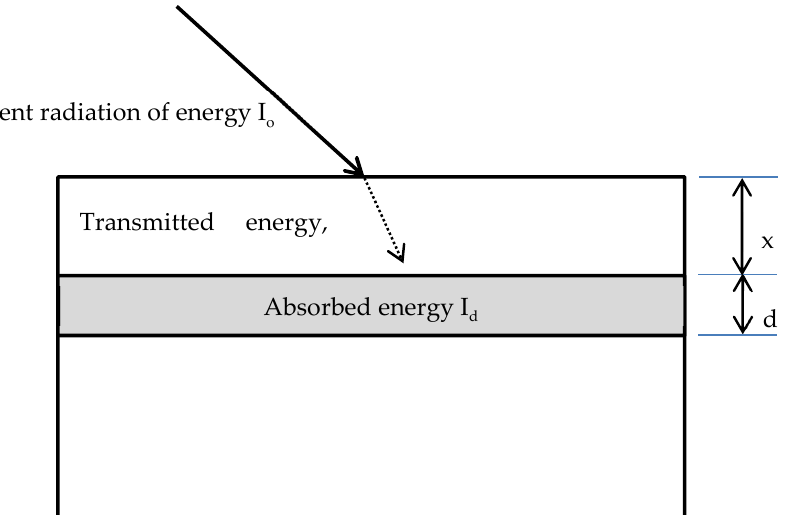
Figure 4. Appl. Sci. 2020 , 10 , x FOR PEER REVIEW